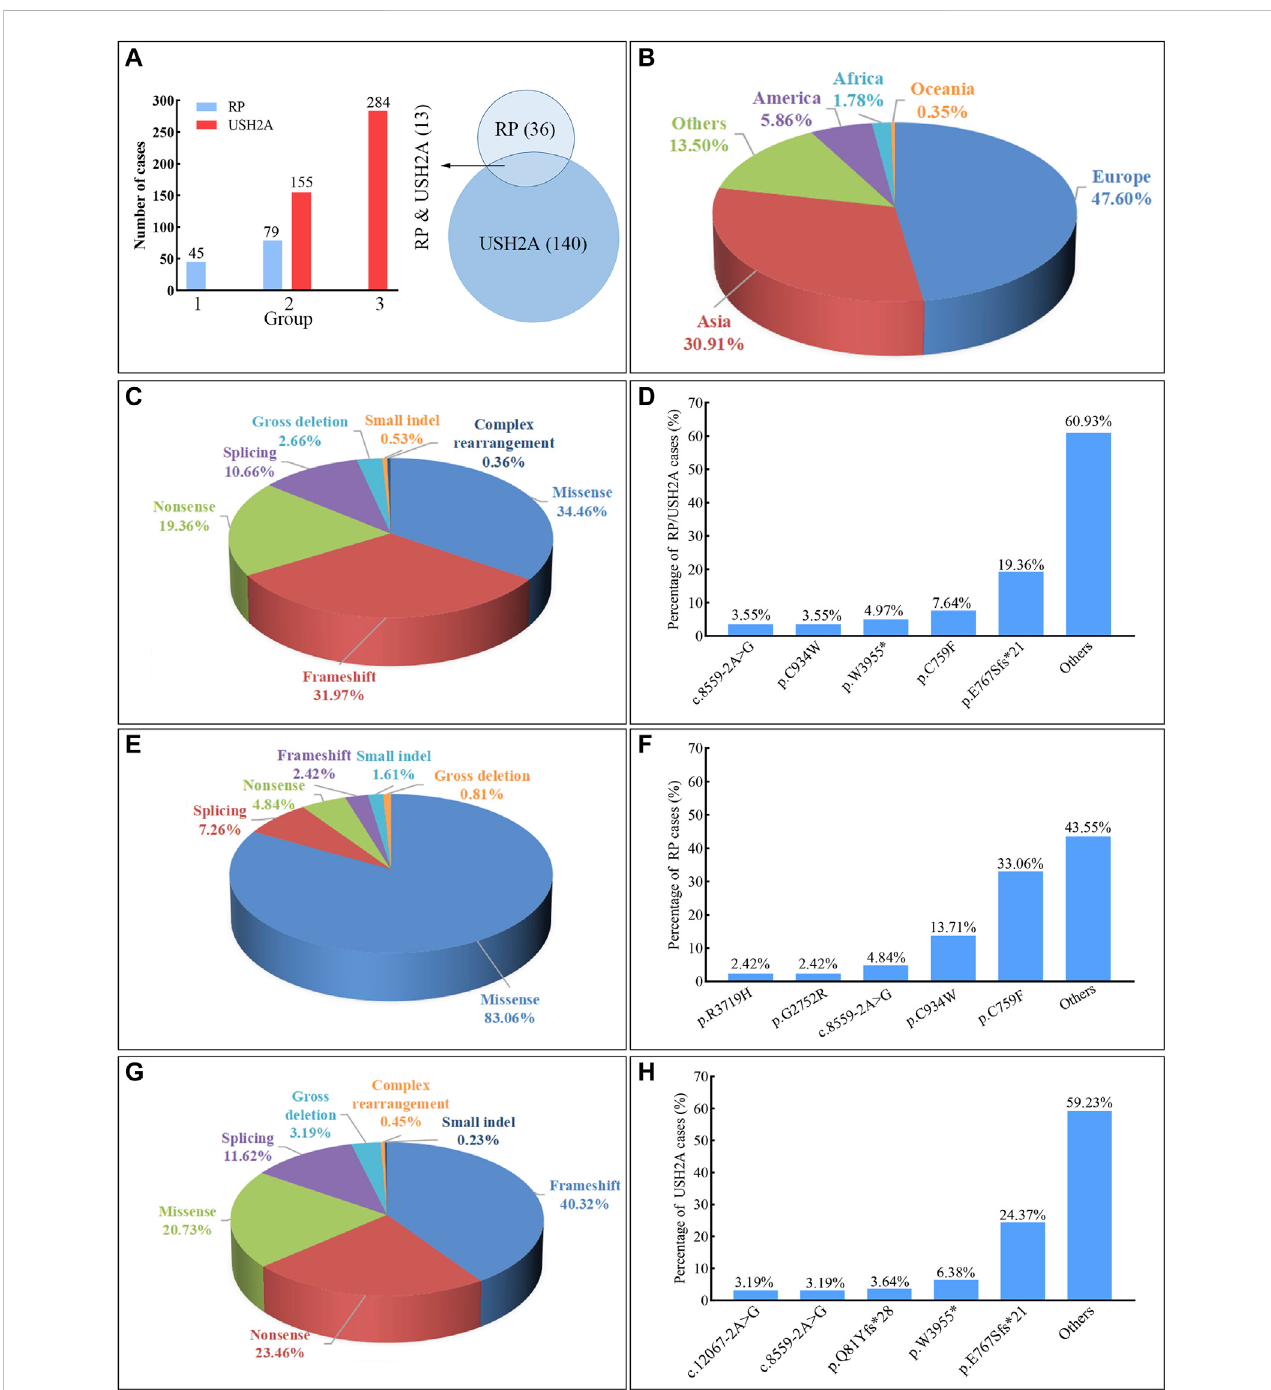
FIGURE 7 Summary of the usherin gene ( USH2A ) homozygous variants associated with retinitis pigmentosa (RP) and Usher syndrome type IIA (USH2A). Frameshift includes small deletion and duplication/insertion with changes involving 20 bp or less leading to reading frame shift. Small indel includes duplication and deletion-insertion with changes involving 20 bp or less leading to one or more amino acids inserted or replaced. Gross deletion or complex rearrangement (i.e.,complexdeletion-insertion)refersto changes over 20bp. (A) The bar chart indicates thecase number ofRP orUSH2A caused byvariousvariants, in which the group “ 1 ” represents the variant causing RP, the group “ 2 ” represents the variant causing both RP and USH2A, and the group “ 3 ” represents the variant causing USH2A. The Venn diagram shows the reported numbers of variants causing RP and USH2A. (B) The proportion of RP and USH2A patients carryingthe USH2A homozygousvariantsindifferentcontinents. (C) TheproportionofcaseswithRPandUSH2Abydifferentvarianttypes. (D) Thepercentage of cases with RP and USH2A observed at different variants. (E) The proportion of cases with RP caused by different variant types. (F) The percentage of cases with RPobserved atdifferentvariants. (G) The proportion ofcaseswith USH2Abydifferentvariant types. (H) The percentageofcaseswith USH2Aobserved at different